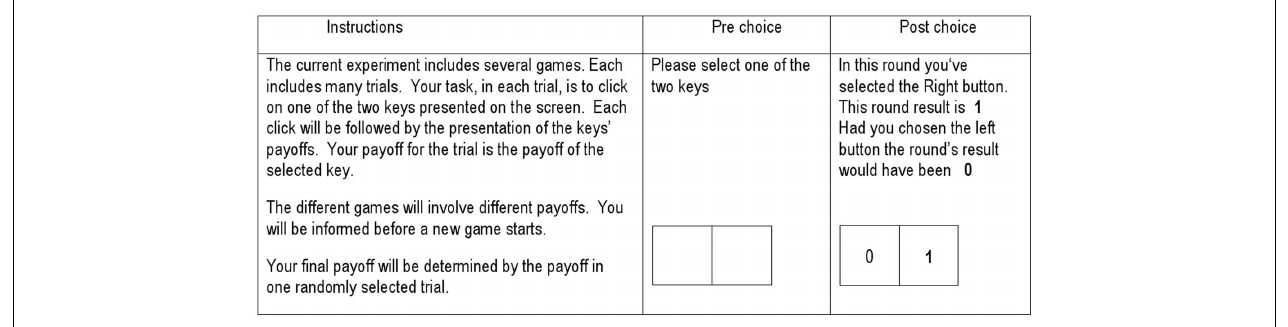
the problems listed in Tables 1, 2, or 3, and included 100 trials. Each key was associated with one of the prospects.The assignment of prospects to buttons and the order of the problems were randomly determined for each participant.